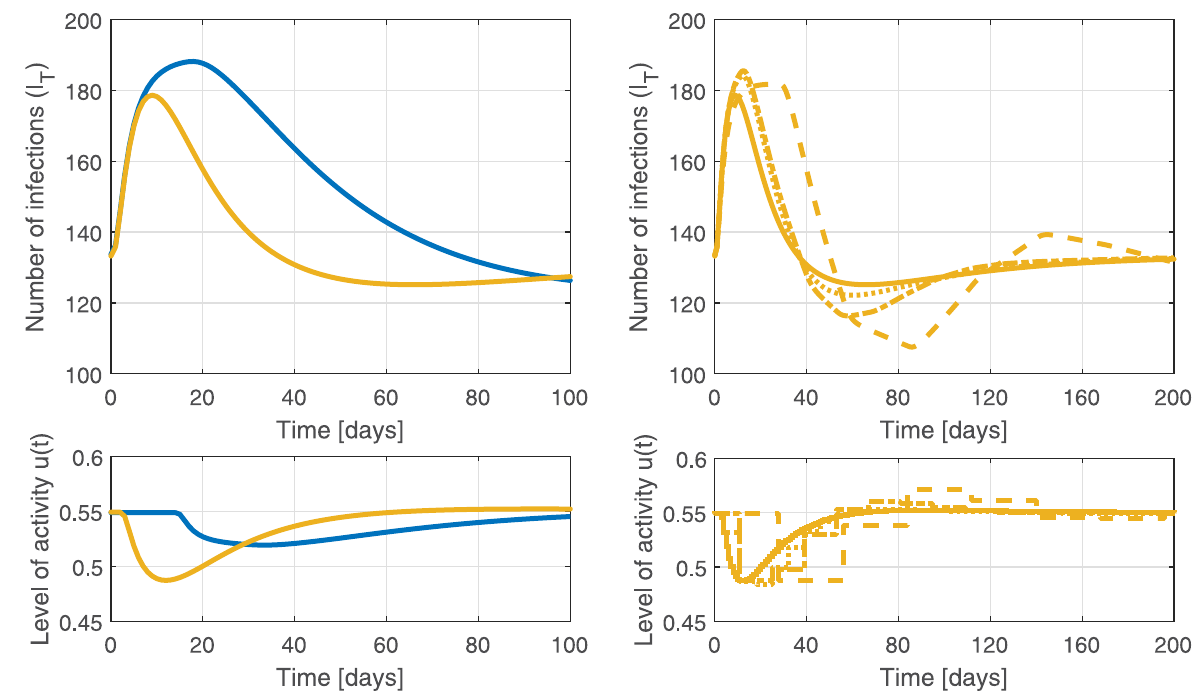
Fig 6. Minimizing delays in feedback improves performance: Left: Delays increase the time to detection of outbreaks and limit how aggressive policy responses can be. The top figure shows the response to an outbreak on day zero (100 exposed individuals). Under feedback with R R 14 days of delay (blue), the case load as a result of the outbreak is I T ( t ) dt = 2022, compared to I T ( t ) dt = 406 for feedback with two days of delay (yellow). The bottom figure shows the corresponding interventions. Reducing the delay also reduces the cumulative interventions required to control the outbreak by 6.7%. Right: The update frequency for interventions needs to be appropriate. When interventions are implemented with daily updates (yellow, as in the left panels), weekly updates (dotted) or updates every two weeks (dash-dotted), we observe similar levels of pandemic control. Updates to interventions every four weeks (dashed) introduce too much delay and cause oscillations.